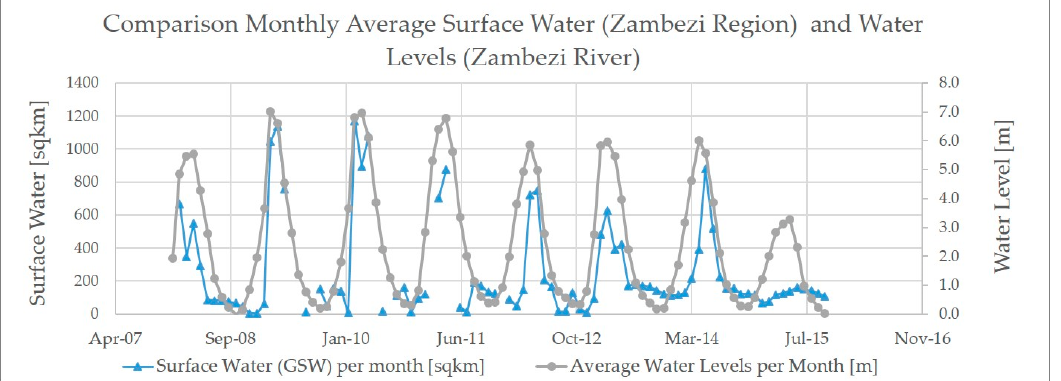
Figure 8. Monthly Average Surface Water and Water Level at Zambezi Region and River.